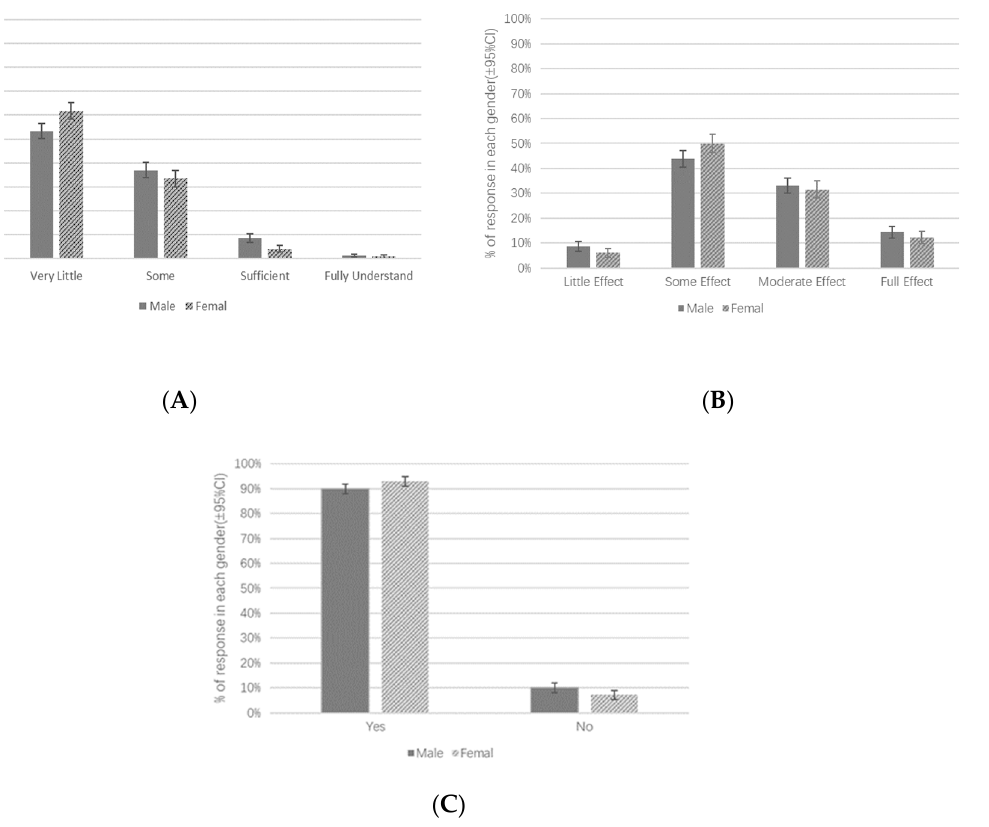
Figure 5. The effect of gender on the perception of the Sponge City program: ( A ) the awareness of the program; ( B ) the effectiveness of the program; ( C ) whether the program should be implemented in other